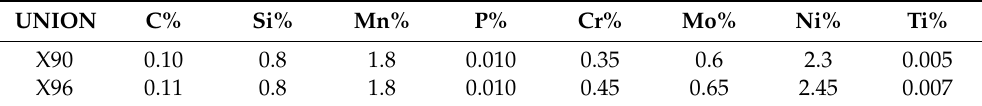
Table 5. Electrode wires—chemical composition of weld metal